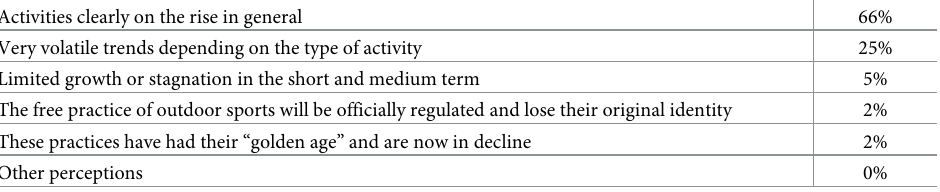
Table 5. Perception of active tourism business owners on the development of the subsector in the short and medium term. Activities clearly on the rise in general 66% Very volatile trends depending on the type of activity 25% Limited growth or stagnation in the short and medium term 5% The free practice of outdoor sports will be officially regulated and lose their original identity 2% These practices have had their “golden age” and are now in decline Other perceptions Source: Survey of active tourism companies in Cordoba complied by the authors.